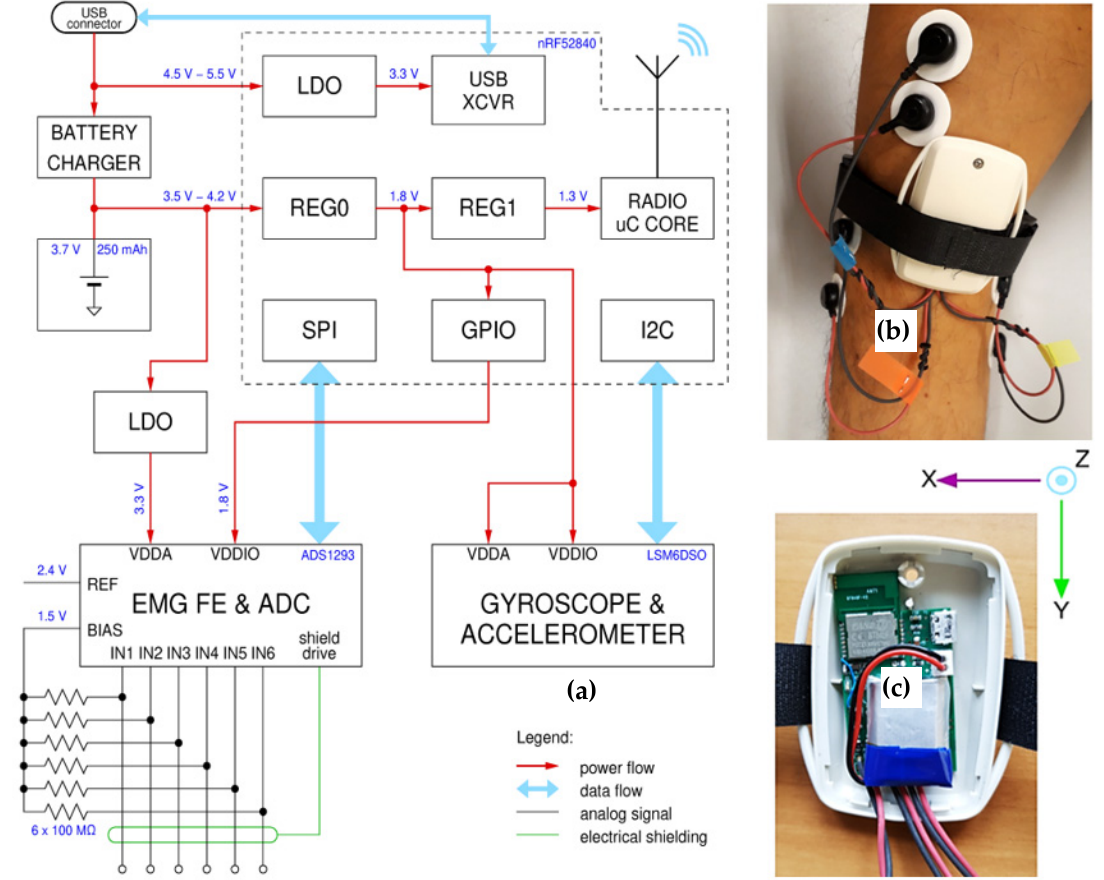
Figure 11. Sensor node architecture with different power supply subsystems highlighted and em- ployed for reducing the power requirements and the data interfaces. When the general-purpose input/output (GPIO) line is active, the ADS1293 collects the analog signals and transfers them to the SoC via a serial peripheral interface (SPI). Using inter-integrated circuit (I2C) communication, the LSM6DSO inertial measurement unit (IMU) provides data from it to the MCU [124] ( a ). The electrodes and electronic section are positioned on the top part of the right forearm, connected to the biceps brachii, triceps brachii, and deltoideus medium (highlighted in yellow, orange, and blue markers, respectively) ( b ). The image on the right below, which depicts the enclosure internal with the battery atop the circuit board, clearly illustrates the mechanical axis’ alignment ( c ). When the device is put on, axes are positioned such that the Y is parallel to the arm and oriented downward at resting, the X is parallel to the sagittal plane and faces forward, and the Z axis is parallel to the coronal plane and faces the arm. (Web-source: https://www.mdpi.com/2079-9292/9/6/934, every aspect related to the human subjects’ involvement has been taken into consideration by the authors in [124]) (Reproduced with permission from [124], MDPI,